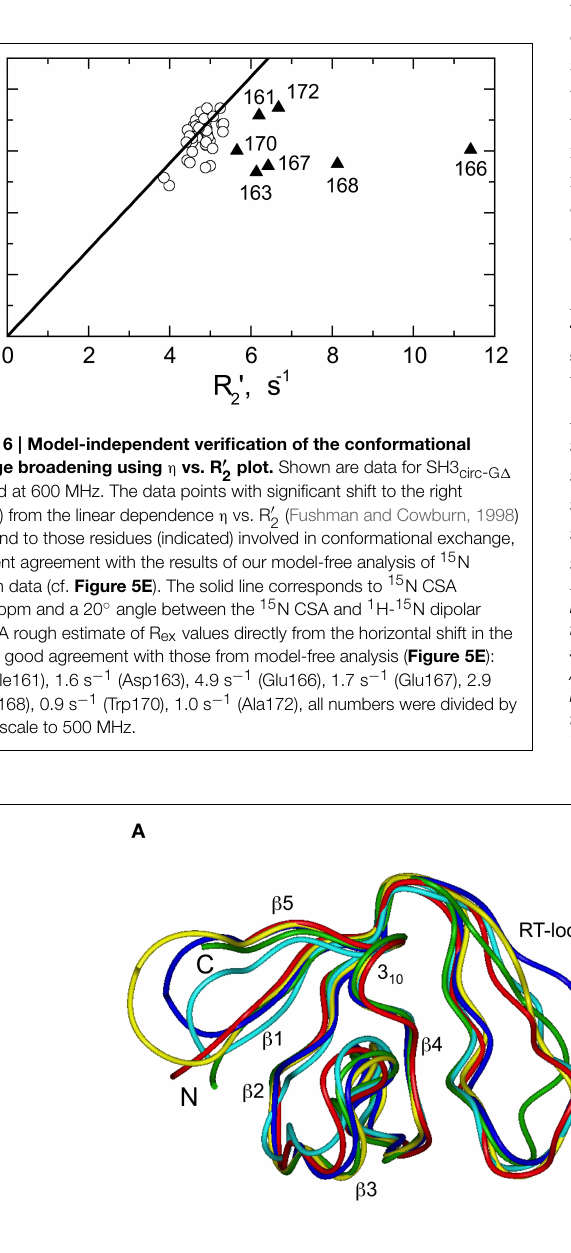
(SH3 circ - wt ). The crystal structure is colored red. These structures were superimposed using backbone heavy atoms for the core residues. The two panels represent two different orientations of the protein: (A) similar to that in Figure 1 and (B) view from the bottom. Elements or secondary structure and the termini are indicated. The drawings were made using